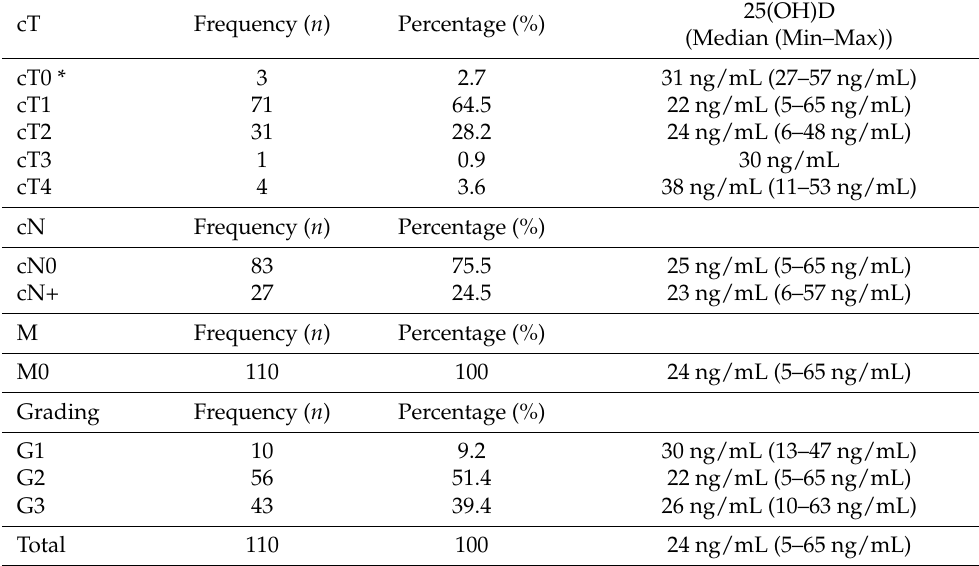
Table 3. Tumor stage and serum 25-hydroxyvitamin D (25(OH)D) levels.